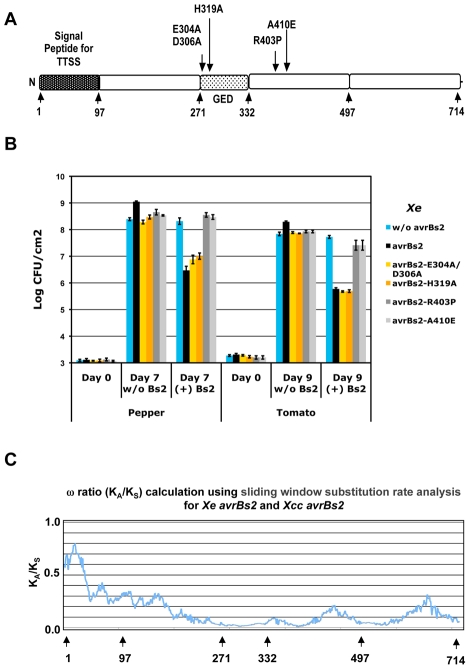
The GDE catalytic sites are required for AvrBs2 virulence function.
A. The map of the AvrBs2 coding region with numbers representing amino acid positions. AvrBs2 mutations for the GDE catalytic site and the AvrBs2 mutations from Xe field strains isolated from diseased BS2 pepper. B. In planta pathogen growth assay for Xanthomonas strains GM98-38 Xe (w/o avrBs2), GM 98-38-1 Xe (avrBs2), and GM98-38-1 exchange mutants for the putative GDE catalytic site Xe (avrBs2-E304A/D306A) and Xe (avrBS2-H319A) and two previously published control exchange mutants Xe (avrBs2-R403P) and Xe (avrBs2-A410E). Host plants include the near-isogenic pepper (w/o Bs2) and pepper (Bs2) along with the tomato line VF36 (w/o Bs2) and the previously published transgenic line VF36 (Bs2). Student t-test was used to compare different growth assays with the most virulent case (Xe (avrBs2) on non-Bs2 plants) for both Pepper and Tomato hosts; p-values were <0.01 for all other combination when compared to (Xe (avrBs2) on non-Bs2 plants). The Xe strains carrying AvrBs2 mutations for the GDE catalytic site still activate full Bs2 resistance but do not maintain the full virulence in the absence of Bs2. There is a corresponding wild type HR brown necrosis phenotype for Bs2 pepper inoculated with high-density suspensions (2×108 CFU/ml) for these two Xe mutant strains (Supplemental Figure S1). The Xe strains carrying AvrBs2 mutations from Xe field strains isolated from diseased Bs2 pepper grow to similar levels in the presence or absence of Bs2. There is a corresponding loss of the HR brown necrosis phenotype for Bs2 pepper inoculated with high-density suspensions of Xe avrBs2-R403P and only a weak HR brown necrosis phenotype for Xe avrBs2-A410E (Supplemental Figure S1). C. Plot of amino acid substitution rate analysis using a sliding window calculation of non-synonymous (KA) and synonymous (Ks) changes between avrBs2 homologs from Xe and Xcc. The KA/Ks ratios less than 0.5 indicate that much of AvrBs2 is under purifying selection, including the region homologous to GDE that is required for AvrBs2 virulence function. The numbers below the plot represent amino acid positions.